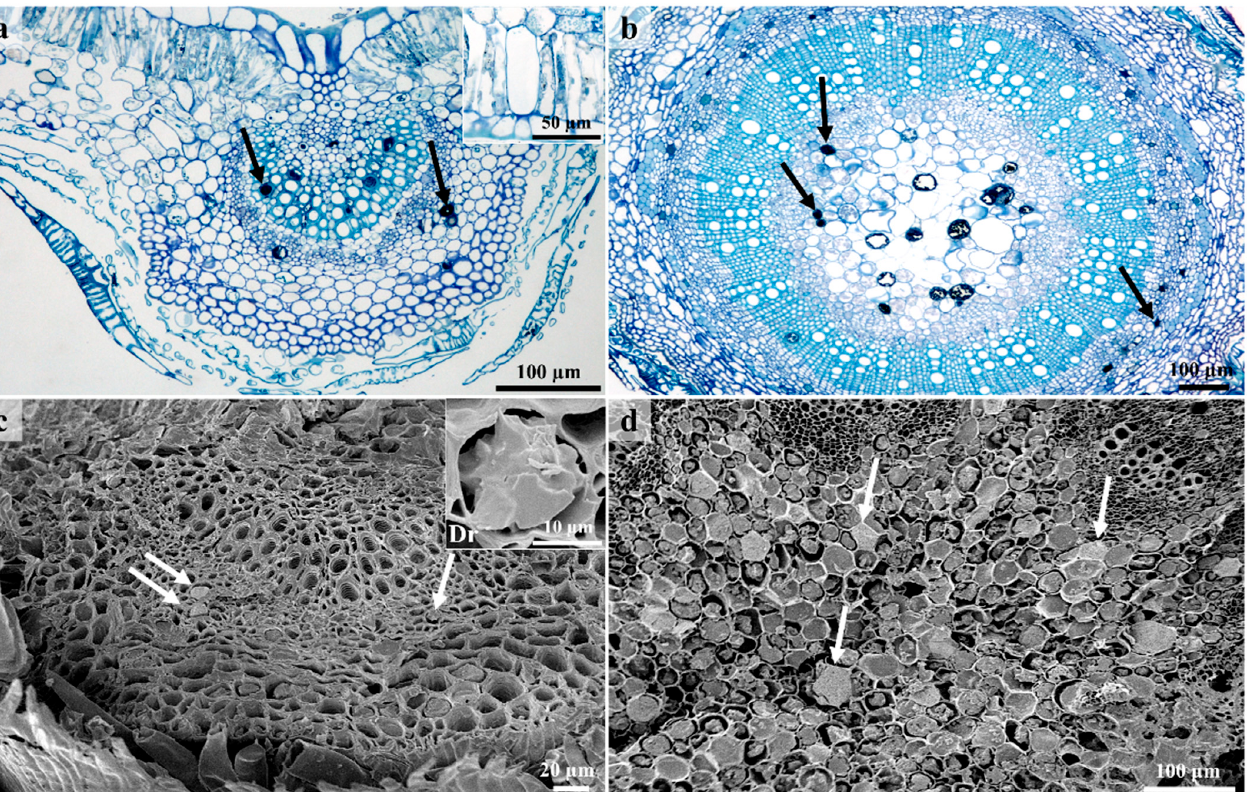
Figure 6. Laticifer distribution in leaves and stems. ( a ) Transverse section of leaf stained with Toluidine blue O showing distribution of laticifers predominantly in the vascular tissue. Note the idioblasts at the adaxial side of the leaf. ( b ) Transverse section of the stem stained with Toluidine-Blue showing laticifers in the phloem and pith. ( c ) Scanning electron micrograph of coagulated latex within laticifer cells (associated with phloem). Druse are also present in the leaf section. ( d ) Transverse section through stem showing latex containing laticifers in pith. Id—Idioblast, Dr—Druse, black arrows—Laticiferous cells, white arrows – latex within laticiferous